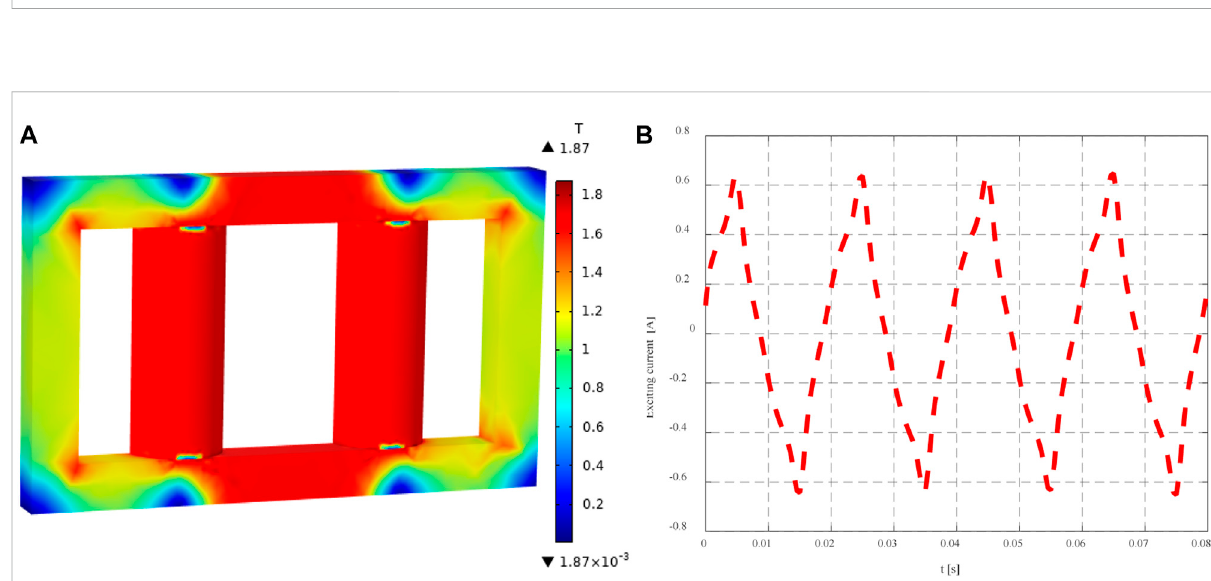
FIGURE 10 Comparison of single-point grounding current effective values of converter transformers under different loads.